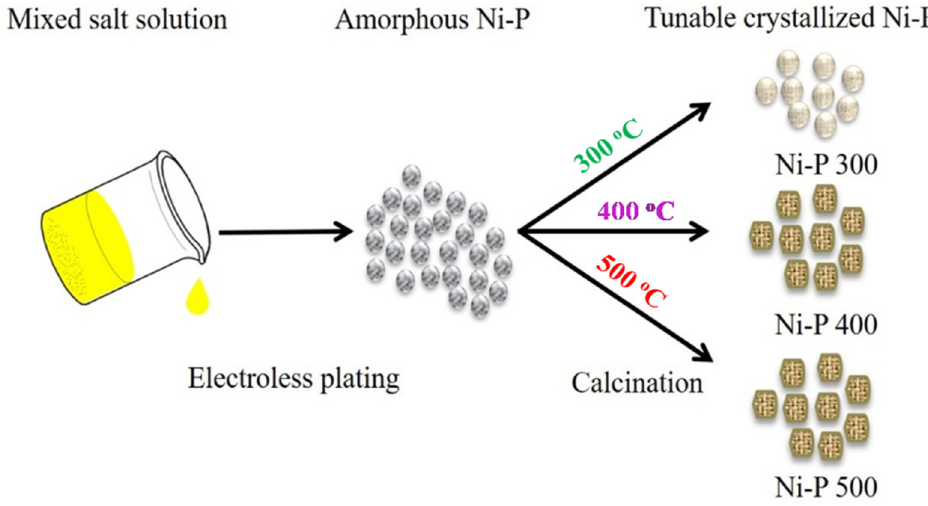
Figure 1. Schematic illustration of synthesis routes of tunable crystallized Ni-P